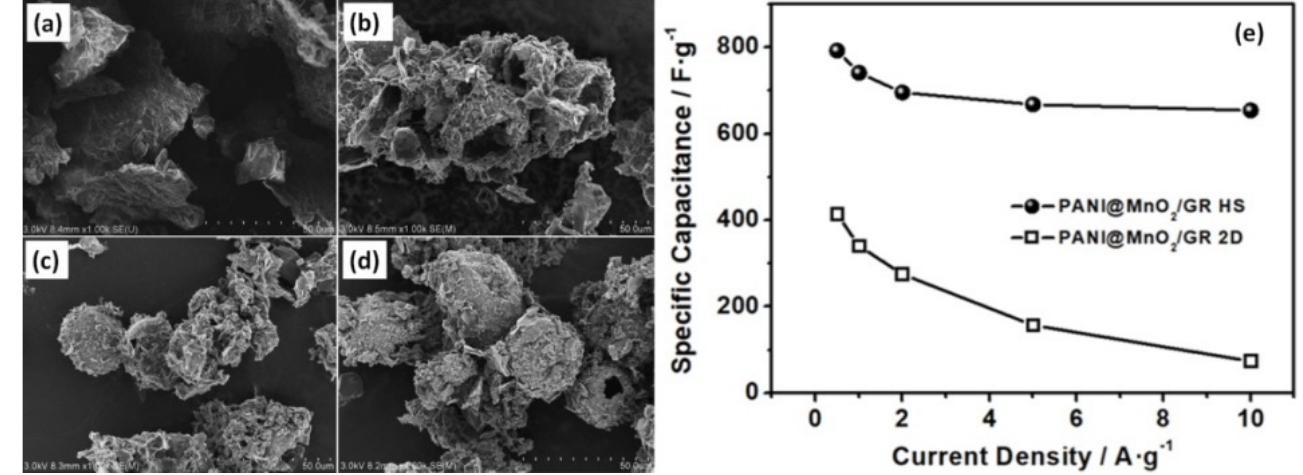
Figure 11. SEM images of PANI@MnO 2 /GR HS prepared with 0 ( a ), 2 ( b ), 4 ( c ), and 10% ( d ) of aniline content in the oil phase for the preparation of HS from KMnO 4 . Specific capacitance vs current density of PANI@MnO 2 /GR HS (prepared with 4% aniline to obtain HS) and PANI@MnO 2 /GR 2D (prepared by direct addition of aniline to the MnO 2 /GR aqueous dispersion) ( e ) (Reprinted with permission from [98]. Copyright 2021 American Chemical Society).